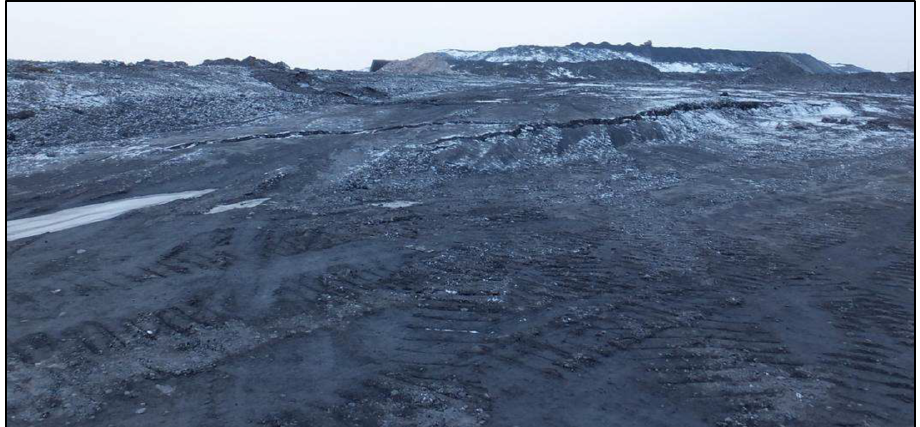
Figure 2. The failure observed on the surface of the Janina mine waste dump (10 February 2017).